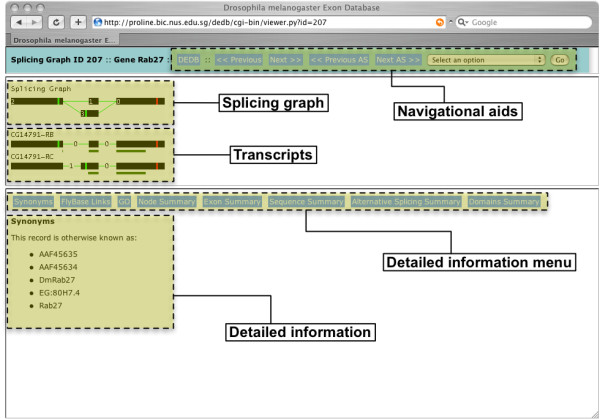
Screenshot of DEDB Splicing Graph Viewer. The viewer is divided into three frames. The top frame contains the navigational aids to allow users to quickly locate the splicing graph of interest. The middle frame shows the splicing graph together with all the transcripts used to generate the splicing graph. The splicing graph and the transcripts are interactive allowing users to click on them for more information in the bottom frame. The bottom frame shows textual information about the splicing graph, which are selectively displayed by either clicking on interactive elements in the middle frame or by clicking on the row of buttons in the bottom frame.